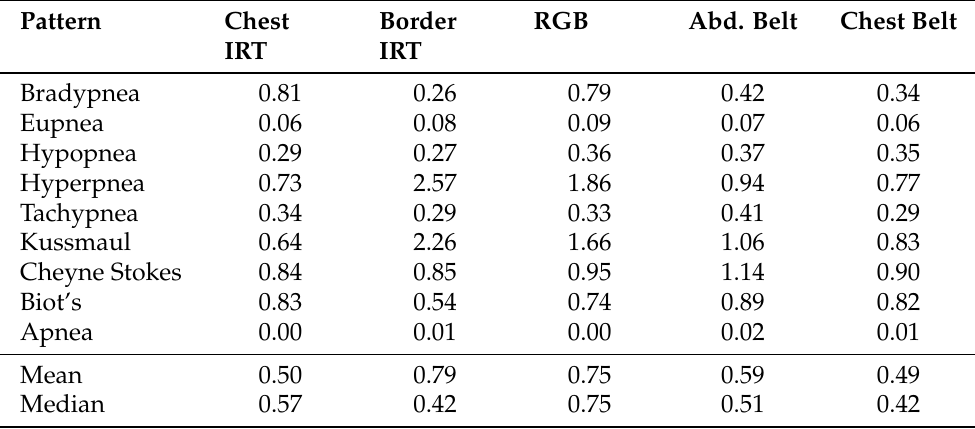
Table 4. Root-mean-square errors (RMSE) for the respiratory amplitude extraction of the different recorded breathing patterns across all modalities. The unit of all values is in normalized units.